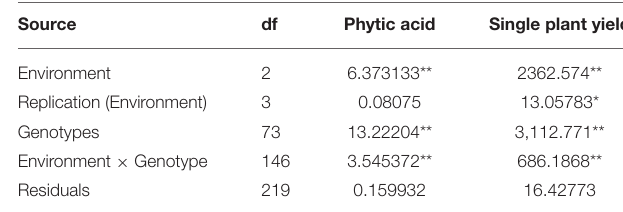
TABLE 4 | ANOVA for pooled analysis of hybrids for yield and phytic acid